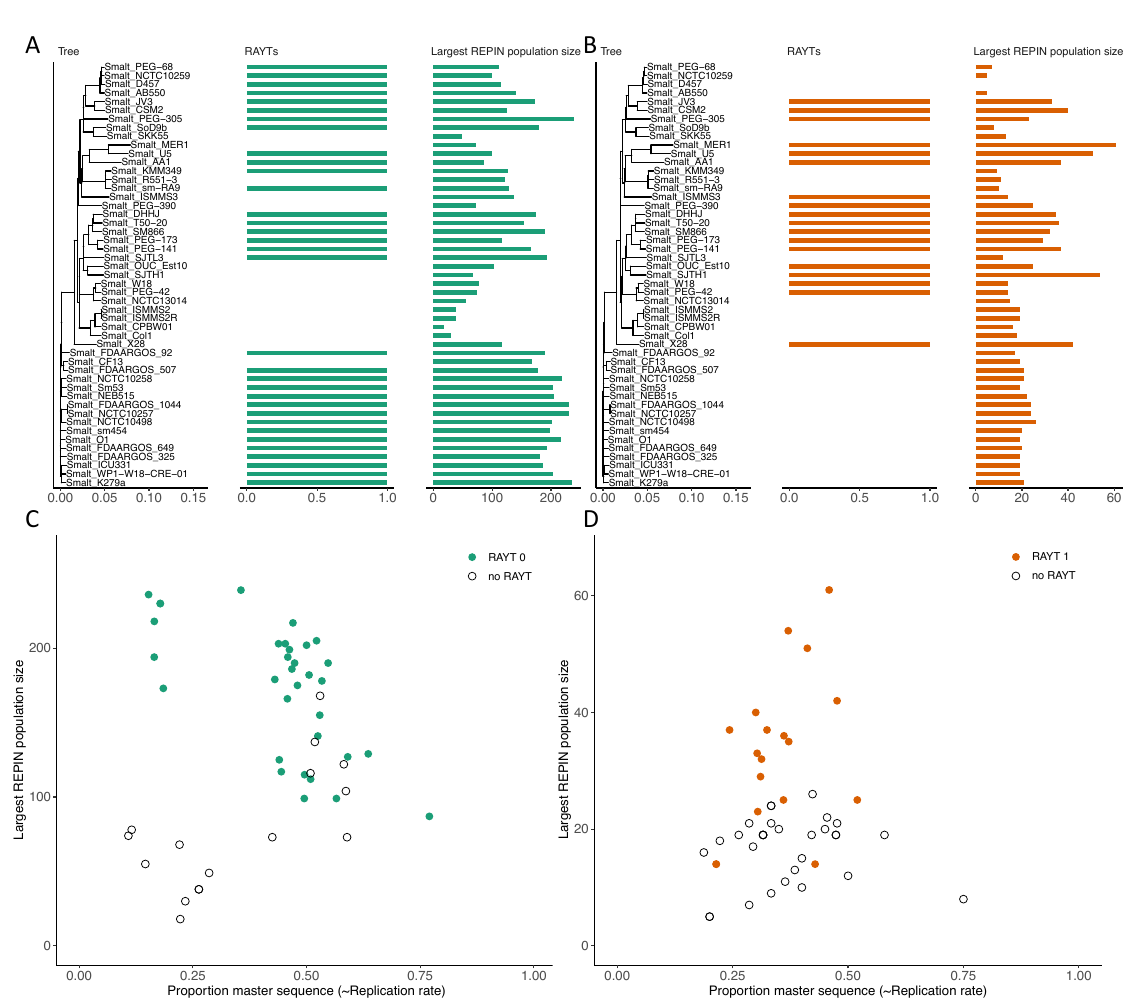
Figure 4 - REPIN population sizes and conservation. The plots show two REPIN populations and their associated RAYTs that were identified in S. maltophilia using S. maltophilia Sm53 as reference . ( A ) The phylogenetic tree on the left side is a whole genome phylogeny generated by andi (Haubold et al. 2015). Shown on the right are REPIN population sizes (which is the largest REPIN cluster calculated by MCL) and the number of associated RAYTs sorted by the genome phylogeny. The green REPIN populations and associated RAYTs are present in most strains in high abundance (maximum of 239 occurrences in S. maltophilia K279a, left panel). ( B ) The orange population in contrast is present in much lower numbers (maximum of 61 occurrences in S. maltophilia MER1, right panel). Note, REPIN populations are assigned consistent colours based on their abundance in the reference genome. For example, the most abundant REPIN population in the reference is always coloured in green, and the second most abundant population is always coloured in orange. ( C and D ) Proportion of master sequence in S. maltophilia REPIN populations. The master sequence in a REPIN population is the most common REPIN sequence. At equilibrium the higher the proportion of the master sequence in the population the higher the replication rate (Bertels, Gokhale, et al. 2017). The presence and absence of an associated RAYT is also indicated by the colours of the dots. Empty circles indicate that the REPIN population is not associated with a RAYT gene in that